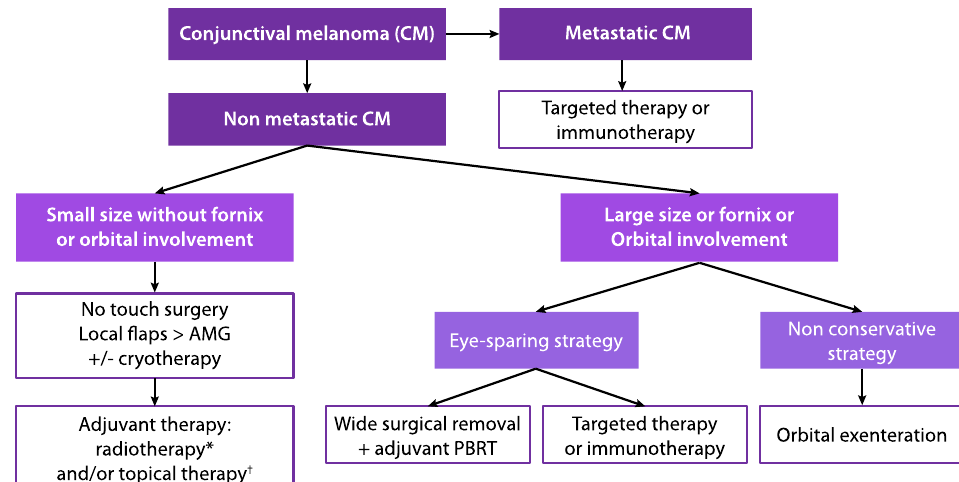
Figure 8. Current management proposal for early-stage and advanced conjunctival melanoma. *proton beam radiotherapy or brachytherapy in case of invasive melanoma; † topical chemotherapy (mitomycin C 0.04%) or topical immunotherapy (interferon alpha 2b) in case of melanoma in situ or primary acquired melanosis with moderate to severe atypia.